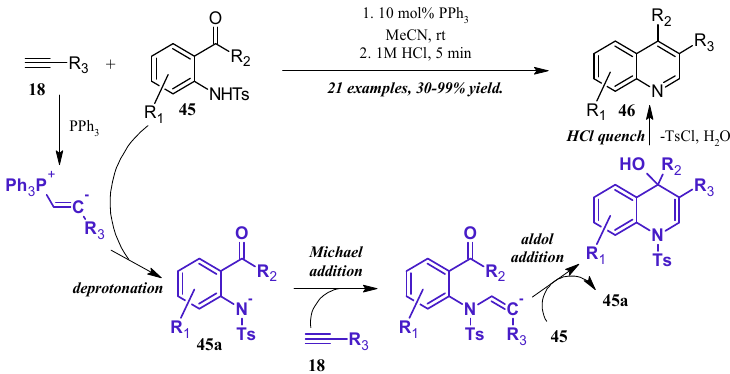
Figure 21. Phosphine-catalyzed Friedländer quinoline synthesis.